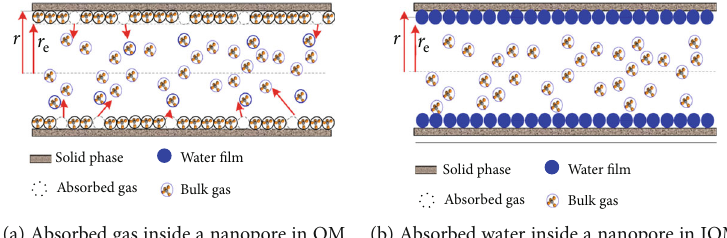
Figure 1: Illustration of absorbed gas/water inside shale nanopores.